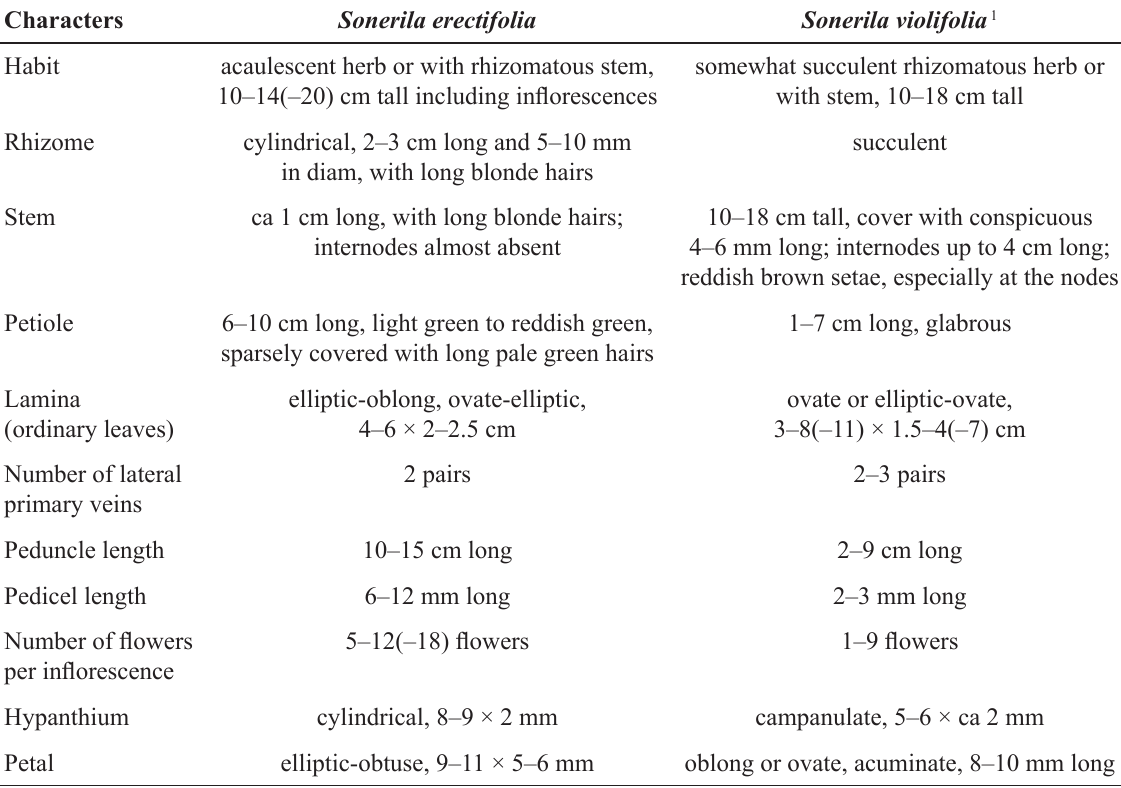
Table 1. Comparison of Sonerila erectifolia Phonep., Soulad. & Tagane sp. nov. and S. violifolia Hook.f. ex Triana. 1 = from Renner et al.